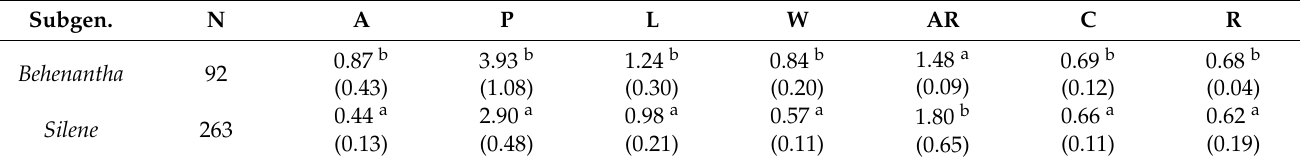
Table 5. Mean values of the area (A), perimeter (P), length of the major axis (L), width (W), aspect ratio (AR), circularity (C) and roundness (R) in the dorsal views of the Silene seeds between species in S . subg. Behenantha and S . subg. Silene . Numbers between parentheses: standard deviation. Superscript letters indicate the results of T-Student: the mean values marked with different letters in each column differ significantly at p < 0.05. N is the total number of seeds analyzed per subgenera.